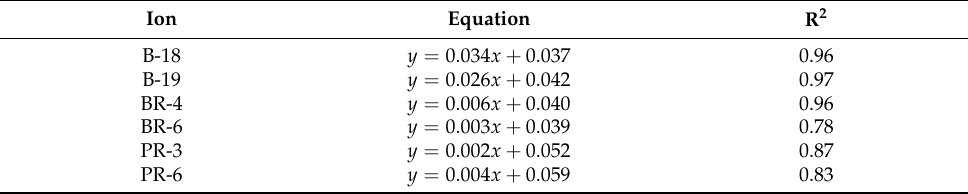
Table 5. Linear regression model for core plugs flooded with 2D*TB EDTA .